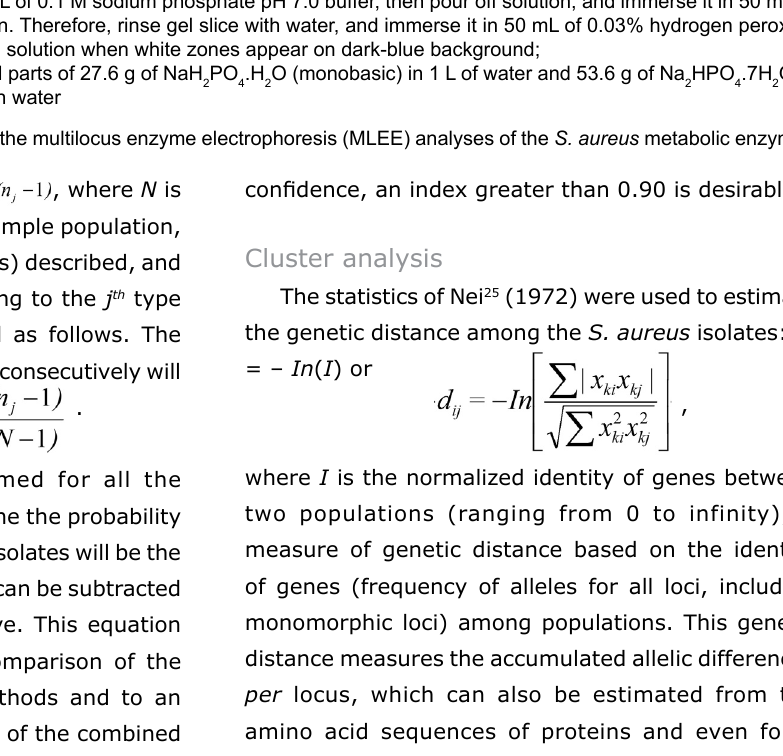
Figure 1- Systems and solutions utilized for the multilocus enzyme electrophoresis (MLEE) analyses of the S. aureus metabolic